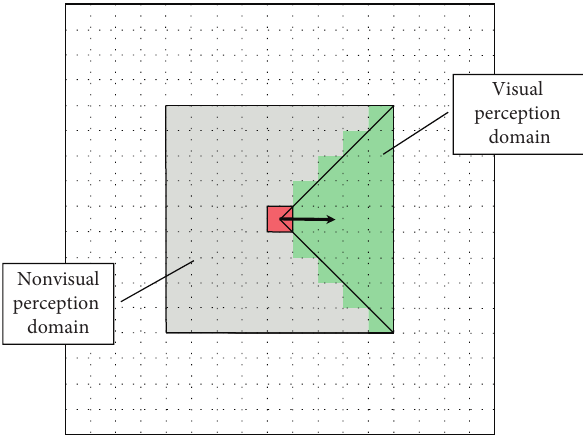
Figure 5: Visual perception domain and nonvisual perception domain when R �